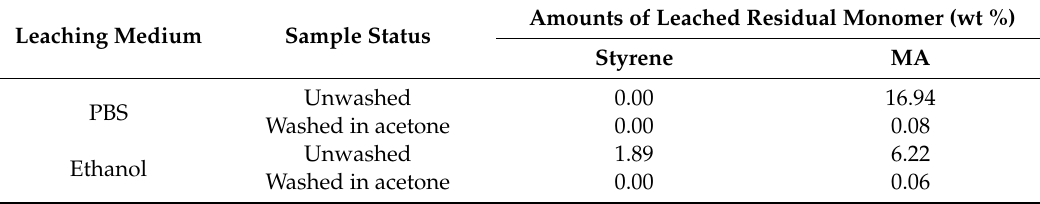
Table 4. The amounts of residual monomers leached into PBS and ethanol from sample polySMA-0.7 determined by